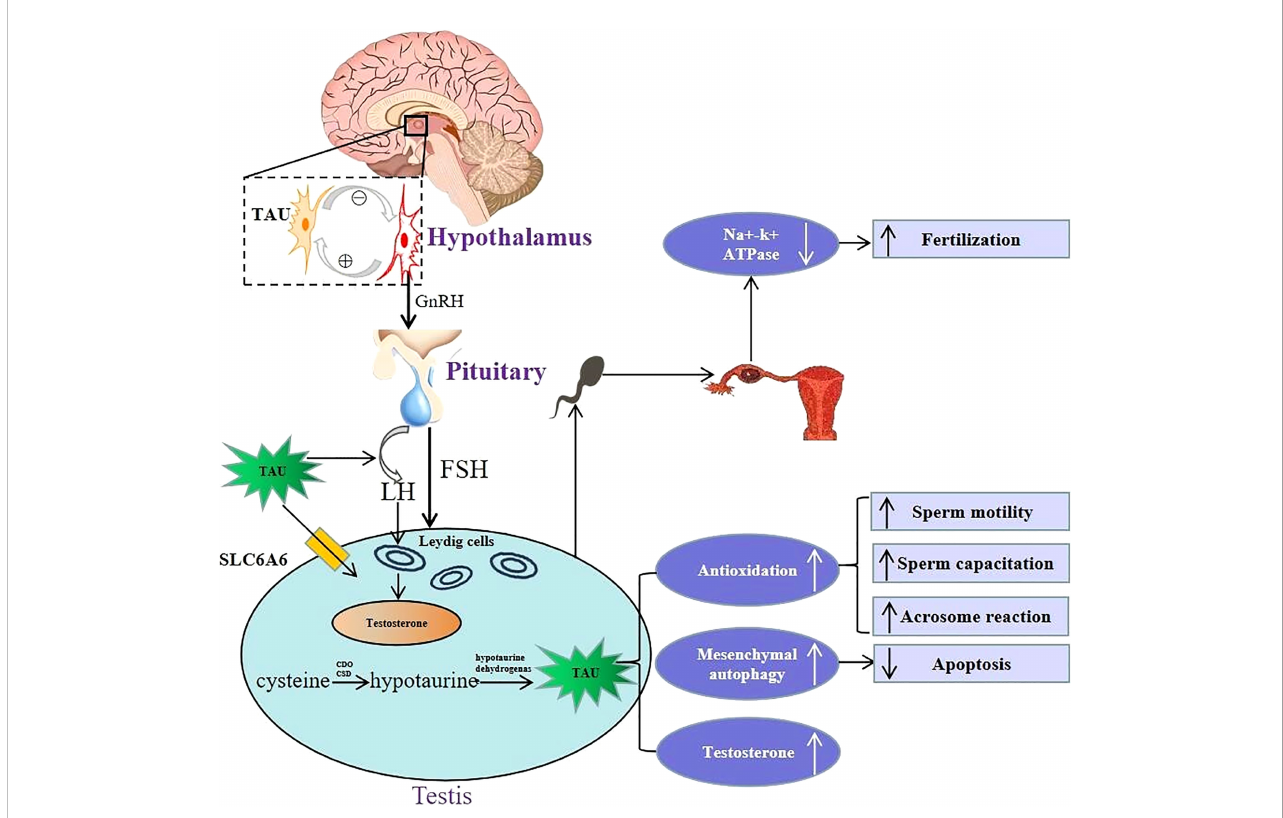
FIGURE 1 Schematic illustration of physiological role of taurine in hypothalamus-pituitary-testis endocrine axis. Top left portion shows the positive and negative feedback between taurine-secreting neurons and GnRH-secreting neurons in the hypothalamus. Lower left portion indicates that taurine regulates the secretion of FSH and LH by directly acting on the pituitary, and then LH acts on Leydig cells to promote testosterone secretion. Moreover, taurine can be transported to testis through transporter SLC6A6, and can also be synthesized endogenously in testis. Lower right portion indicates that the physiological mechanism and effects of taurine in testis, including: (i) enhancing antioxidation to promote spermatogenesis, sperm capacitation and acrosome reaction; (ii) enhancing the autophagy process of interstitial cells to inhibit cell apoptosis; (iii) promoting the secretion of testosterone. Top right portion shows in the fallopian tube, taurine reduced cellular K+ in fl ux by inhibiting Na + – K + ATPase activity, thereby avoiding high K+ inhibition of sperm motility to promote conception. TAU, taurine; SLC6A6, Sodium-and chloride-dependent taurine transporter; CDO, cysteine dioxygenase; CSD, cysteine sul fi nate decarboxylase; GnRH, gonadotropin-releasing hormone; FSH, follicle-stimulating hormone; LH, luteinizing